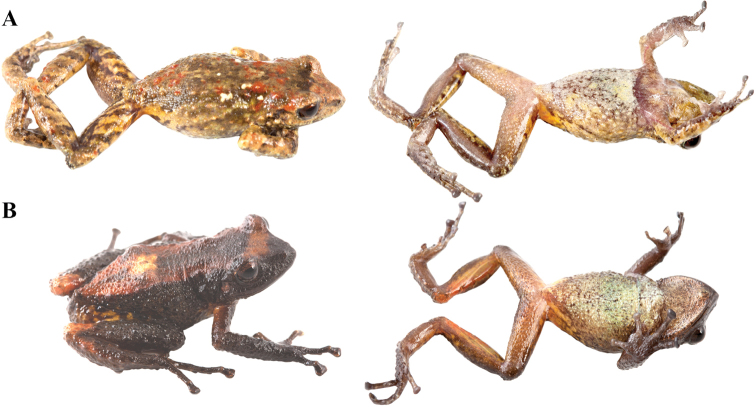
Color variation in live individuals of Pristimantis
teslai sp. nov. AQCAZ 46208 (male, SVL 23.4 mm) BQCAZ 46209 (juvenile female, SVL 29.4 mm). Dorsolateral view on the left, ventral view on the right.